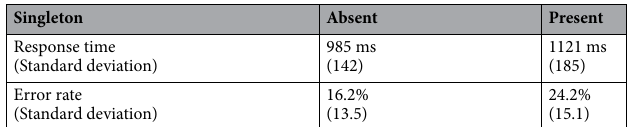
Singleton Absent Present Response time (Standard